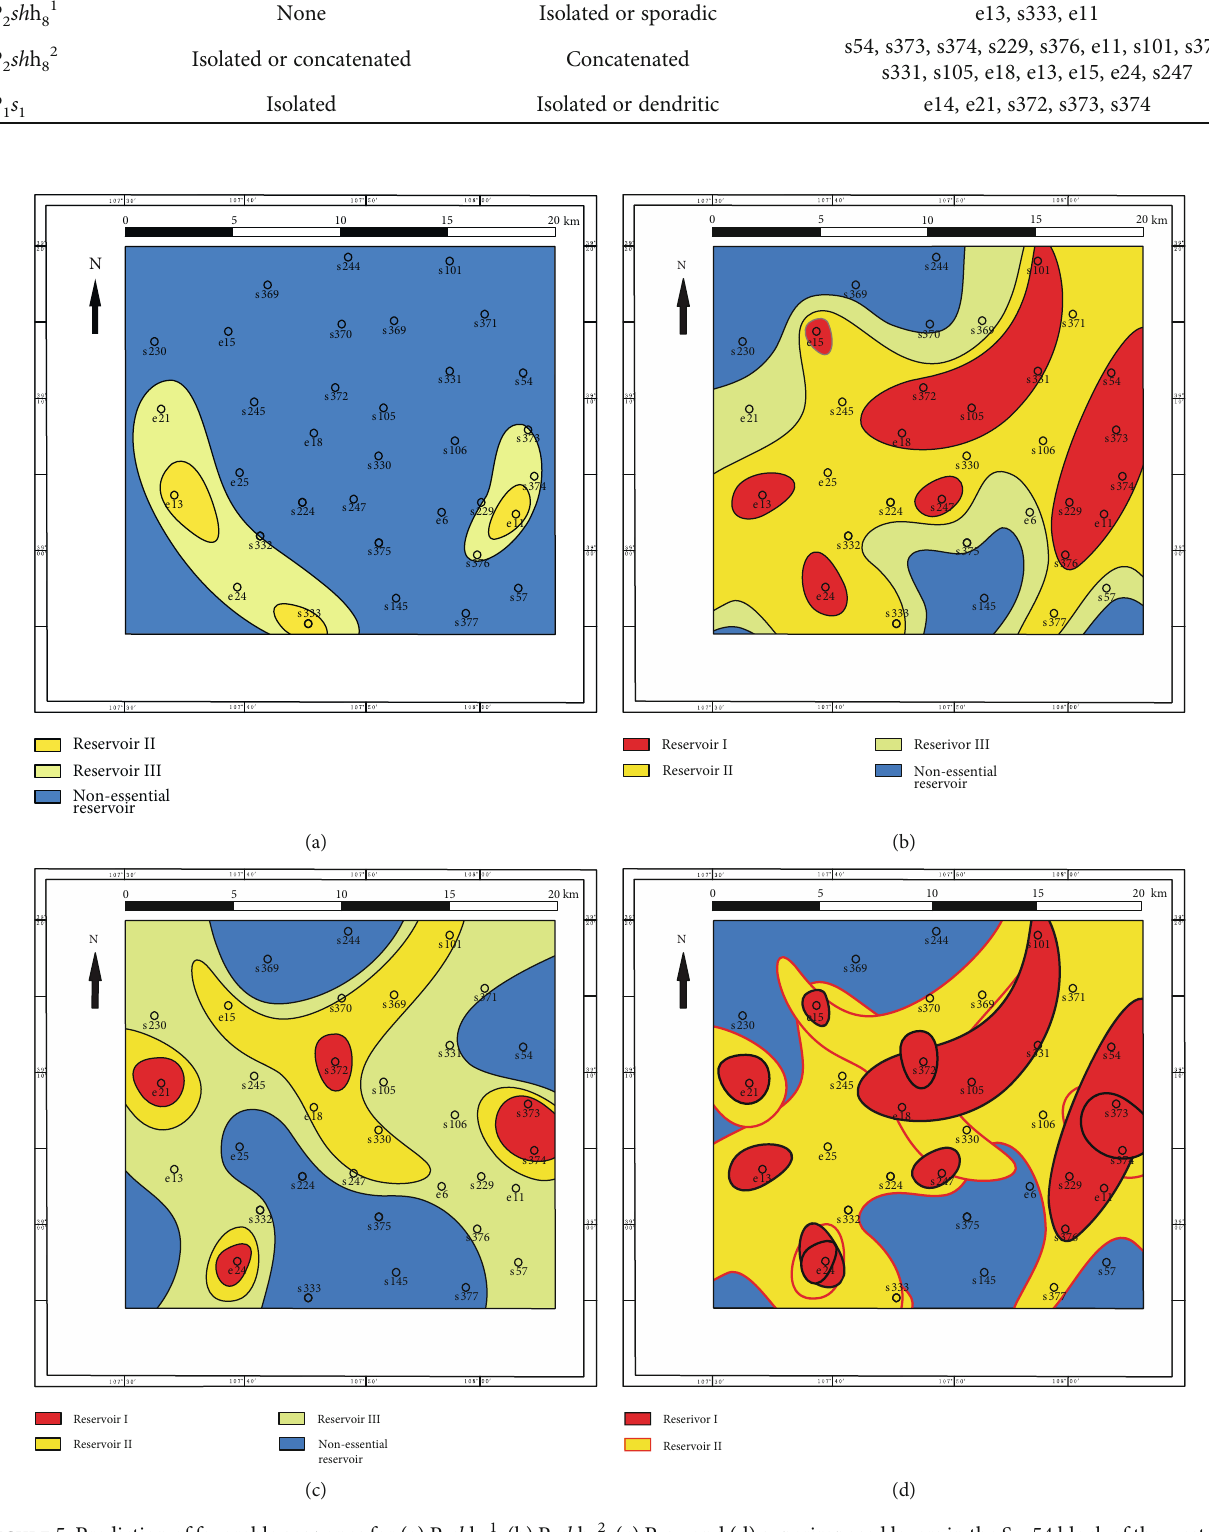
sh h 81 , (b) P sh h 82 , (c) P s , and (d) superimposed layers in the Su-54 block of the western 2 2 1 1